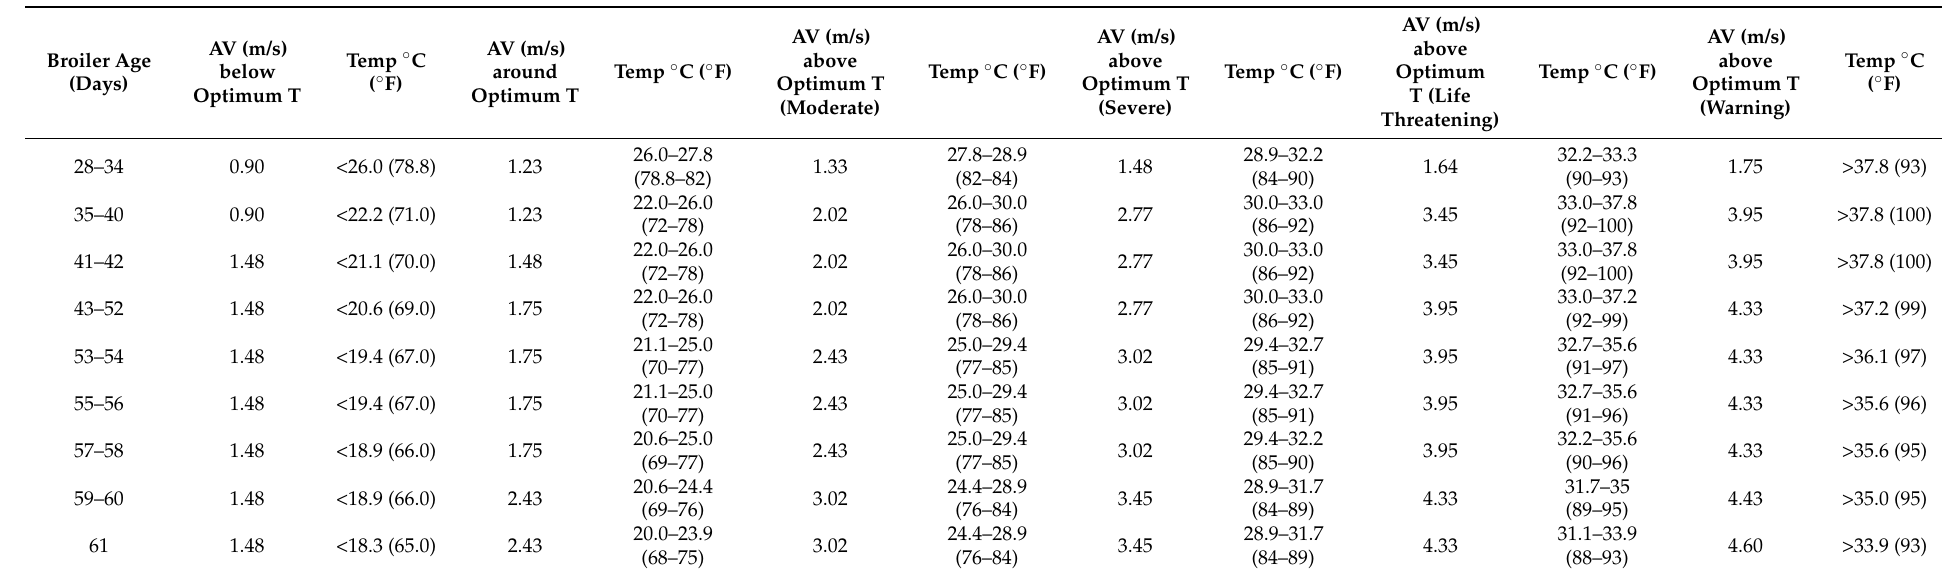
Table 1. High AV treatment